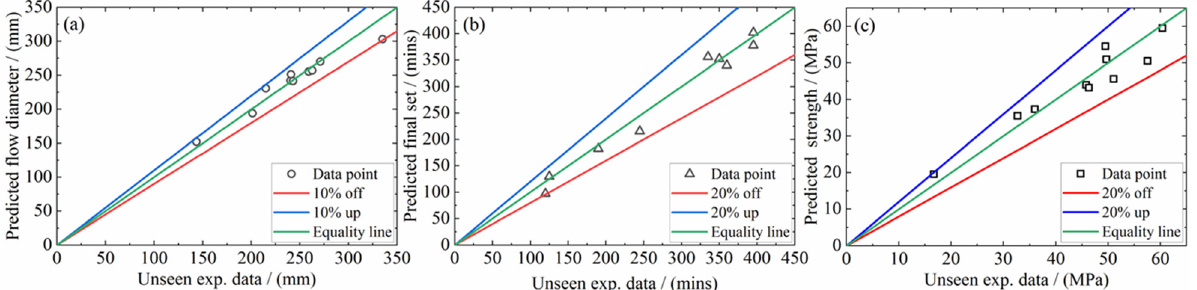
Figure 13. Comparing predicted results with validation dataset for ( a ) flow diameter, ( b ) final set- ting time and ( c ) compressive